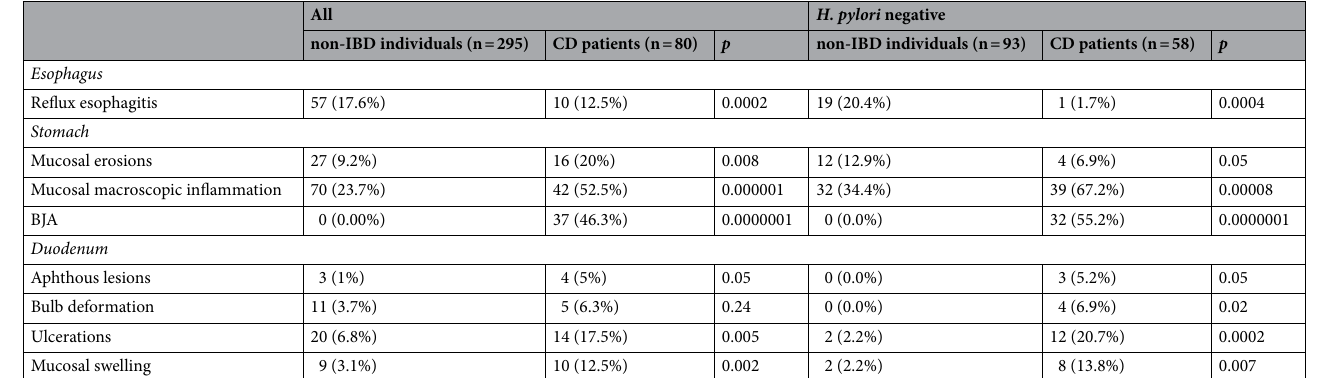
Table 1. Significant differences in the prevalence of certain types of endoscopic findings among patients with Crohn’s disease and healthy individuals (together with statistical comparison). Analyses were conducted separately for whole population of recruited individuals and separately for H. pylori negative population of non-IBD and CD patients. BJA bamboo joint-like appearance, CD Crohn’s disease, IBD inflammatory bowel disease. p level of significance.